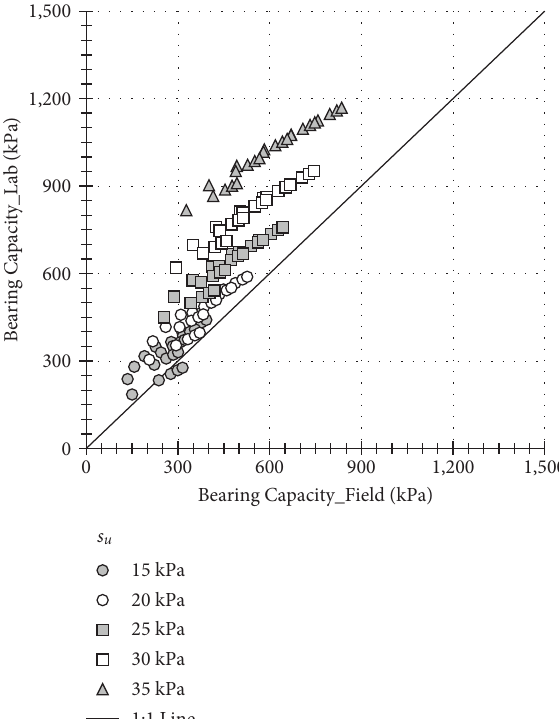
Figure 9: Comparison of observed and predicted ultimate bearing capacity of the proposed MLR models for approach